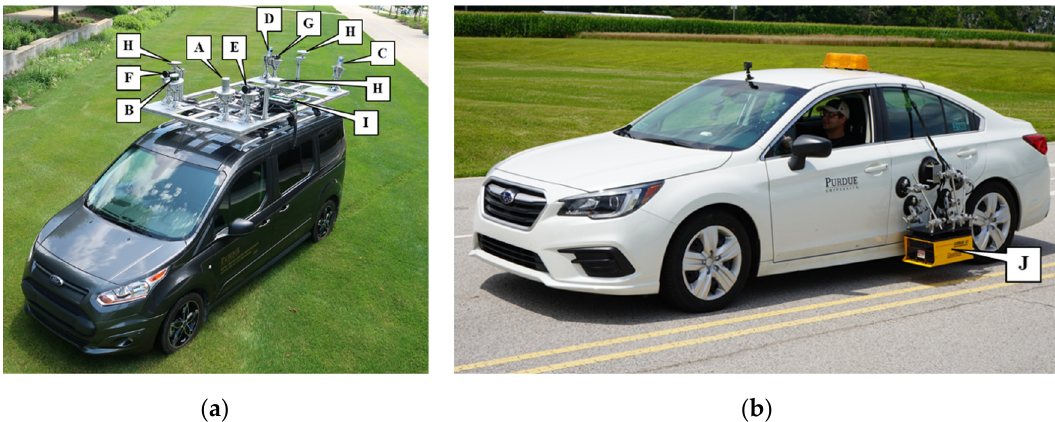
Figure 2. LiDAR and retroreflective data collection equipment and configuration: ( a ) Purdue mobile mapping system for LiDAR data collection and ( b ) Road Vista LLG7 mobile retroreflectometer for retroreflective data collection.